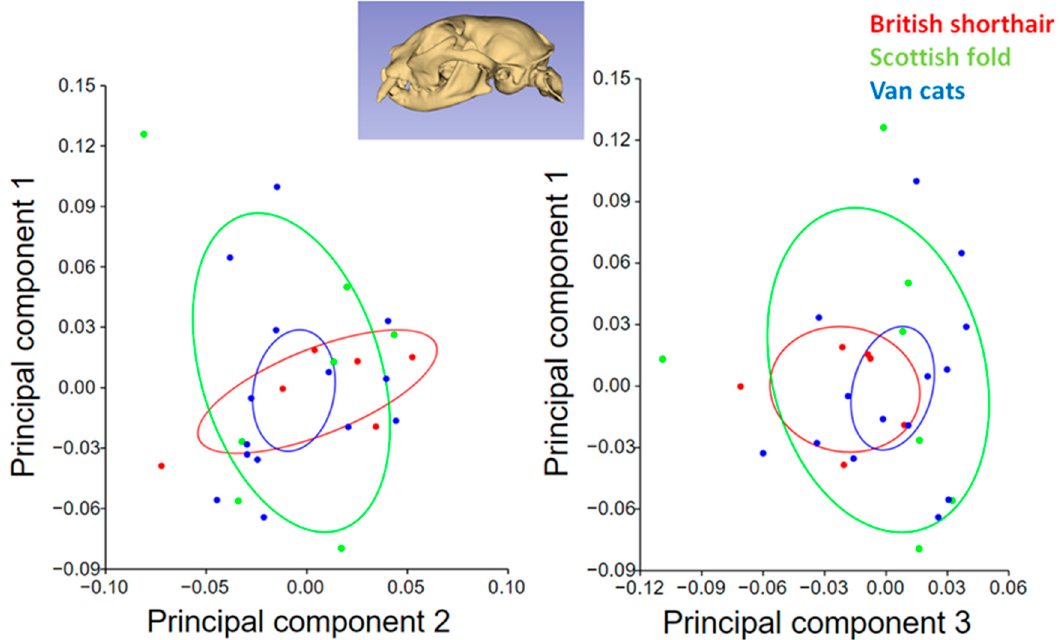
Figure 5. Principal component analysis scatter plot comparing skull morphology of cat breeds (lateral view). Ellipses represent 95% confidence intervals around the means. Table 3. Centroid size and standard deviations of cat skulls.